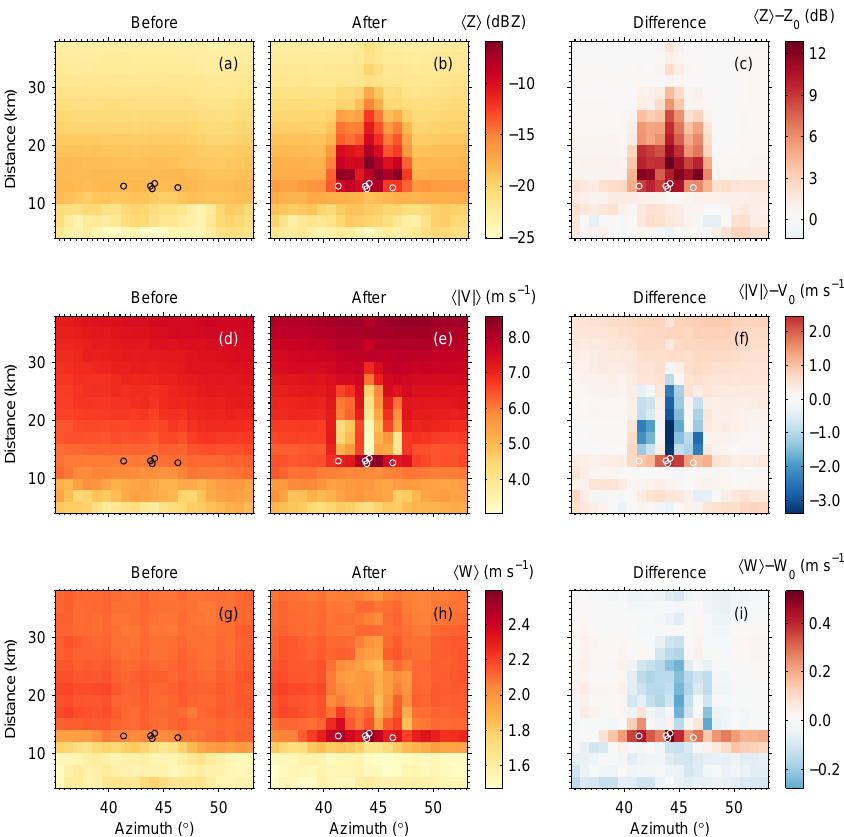
Figure 2. The columns to the left and in the middle show average reflectivity, (cid:104) Z (cid:105) ; average absolute radial velocity, (cid:104)| V |(cid:105) ; and average spec- trum width, (cid:104) W (cid:105) , before and after the construction of the Brunsmo wind farm. The right-hand column shows the difference (after − before). The locations of the wind turbines are shown with black or white circles. The impact of the wind turbines is seen for all spectral moments as changes to their average value. The impact of the wind turbines extends to radar cells both cross- and downrange from the wind